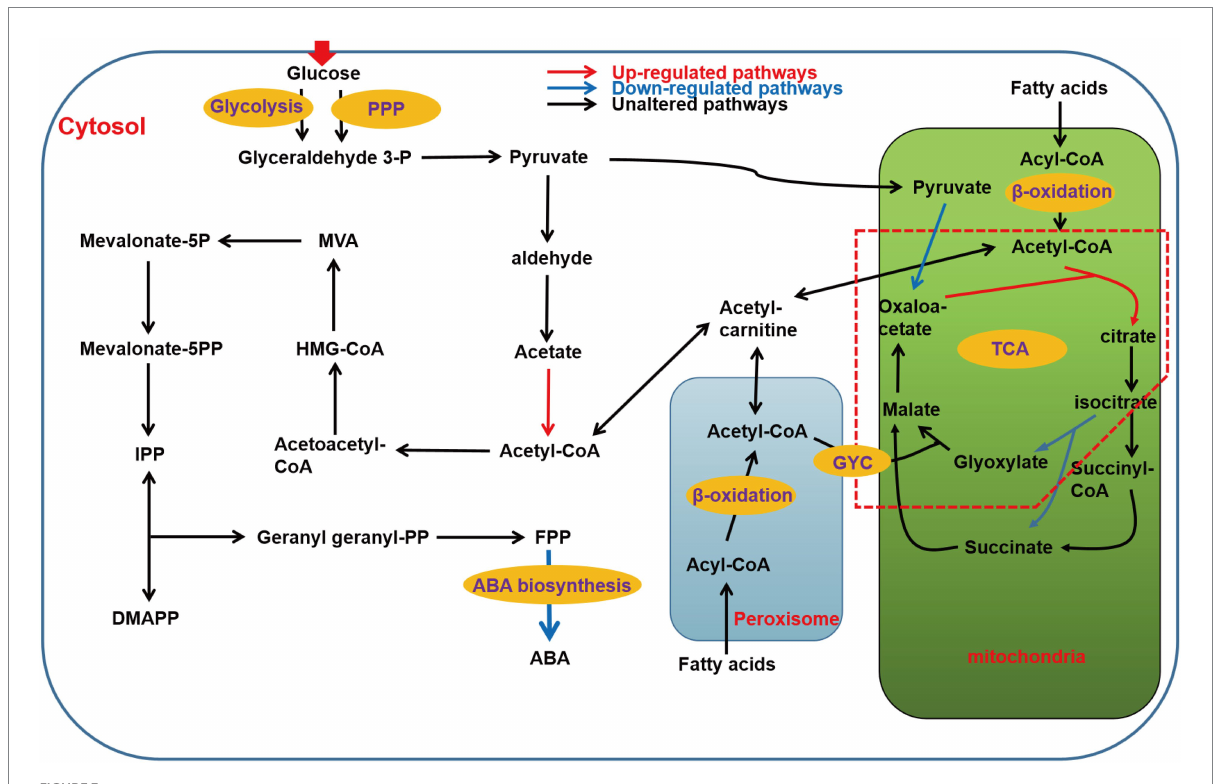
FIGURE 3 Schematic of metabolic pathways associated with ABA production affected by Bclae1 deletion. The red arrows indicate upregulated pathways, blue arrows indicate downregulated pathways, and black arrows indicate pathways that were not observably regulated. The red dashed box annotates the GYC pathway (log2 |fold change| ≥ 1, value of p < 0.05 and RPKM of at least one sample larger than